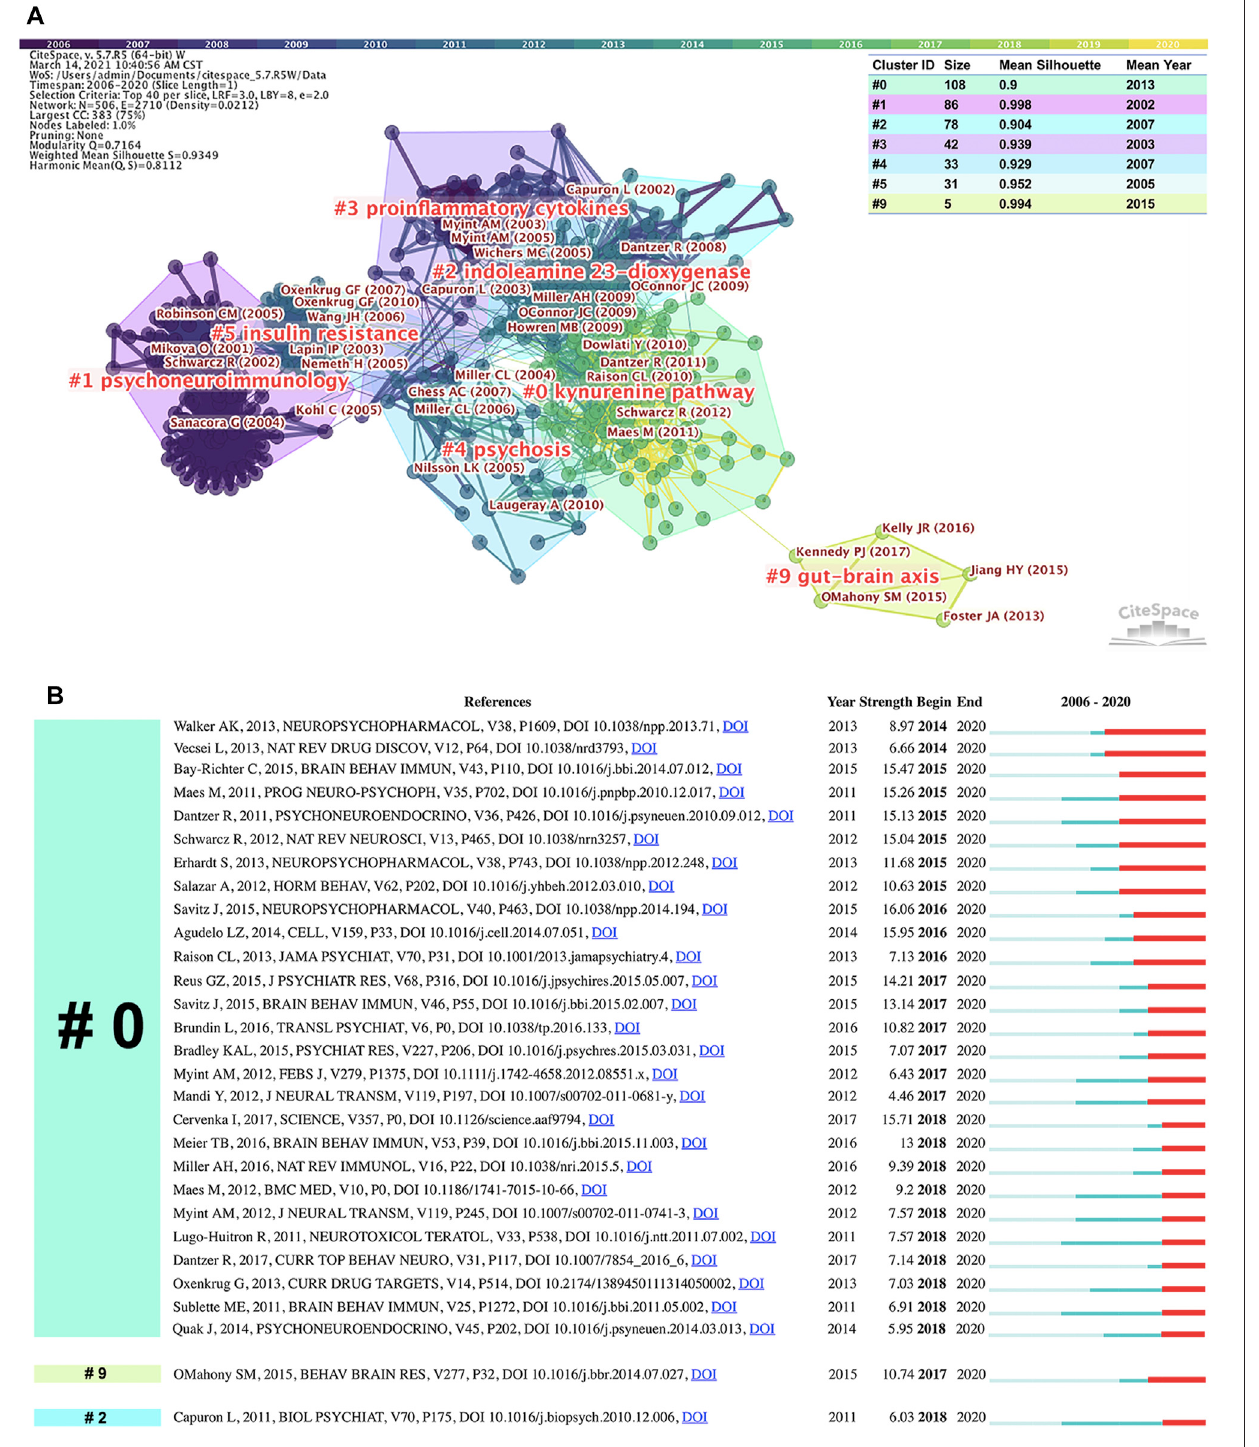
Frontiers in Pharmacology |